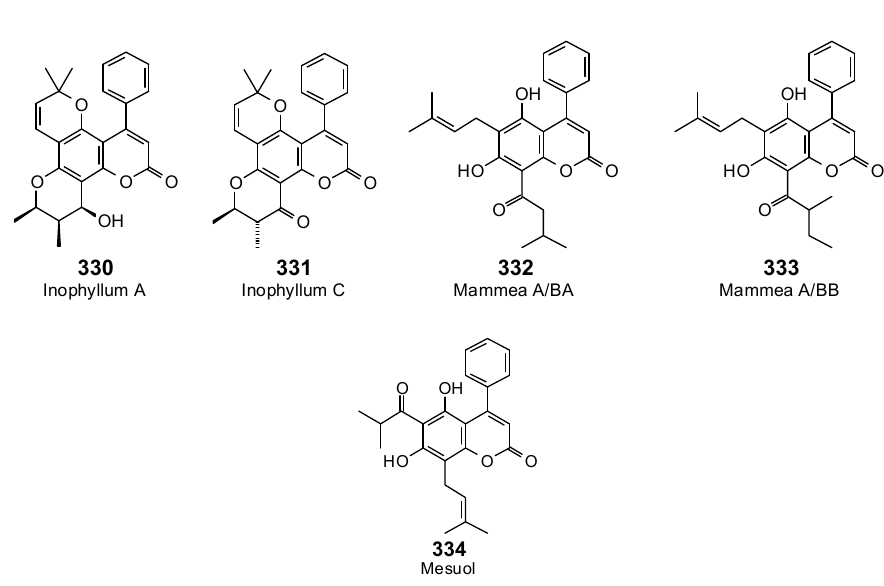
Figure 11. Isoflavonoids examined in this work.